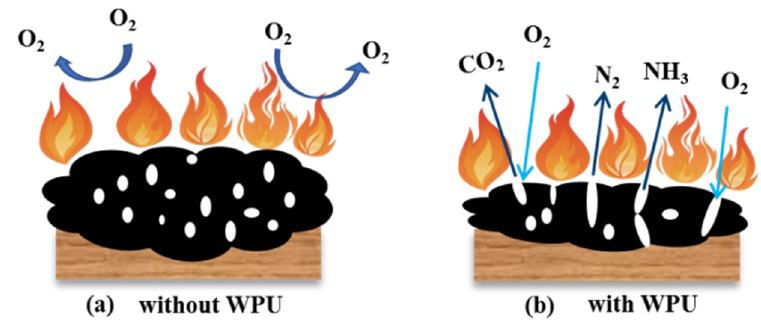
Scheme 1. Expansion process of the char ( a ) with and ( b ) without WPU.